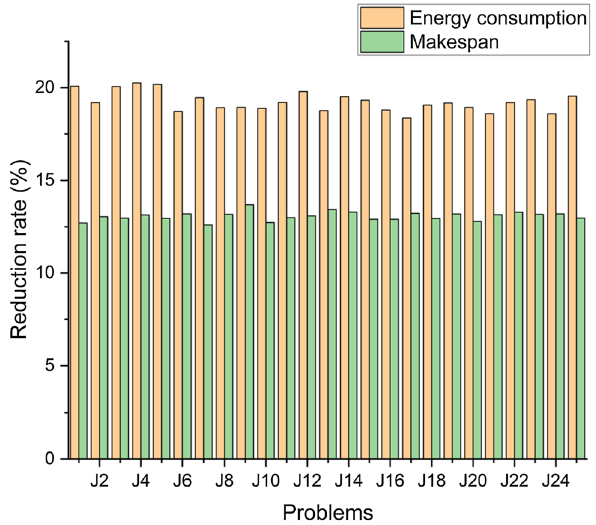
Fig. 8 The energy consumption reduction rate and makespan reduc- tion